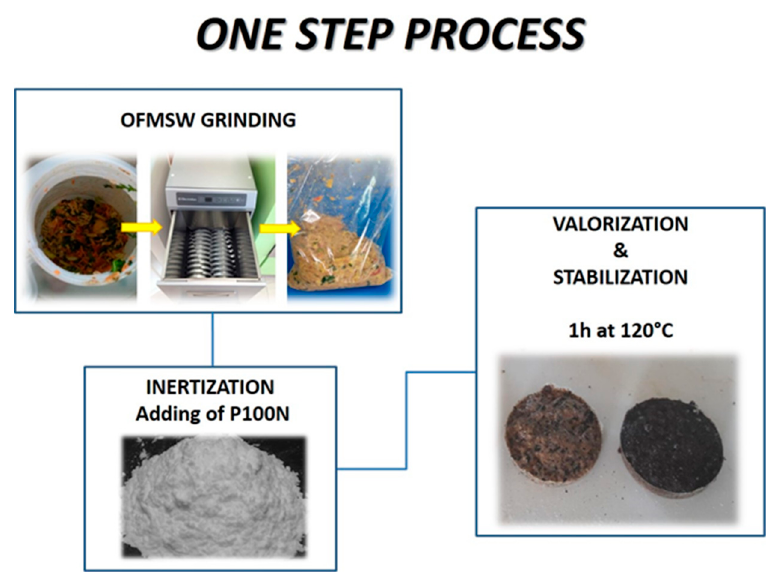
Figure 2. Simplified scheme relative to the one step OFMSW-treatment process.